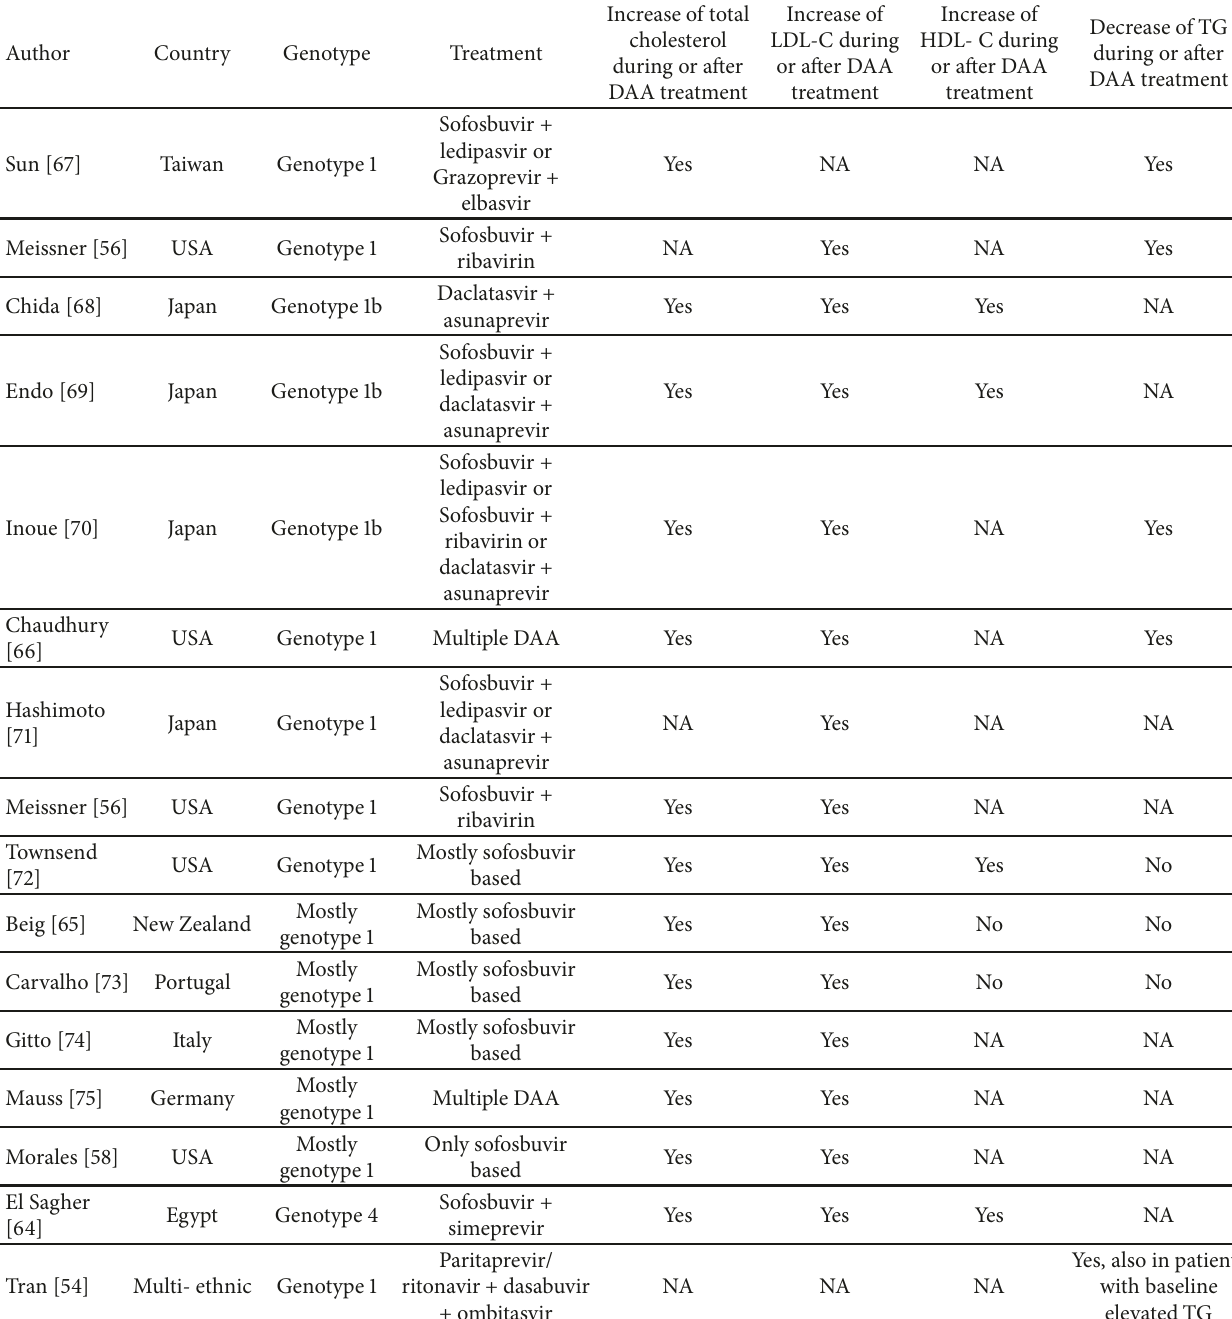
Table 2: Studies reporting the changes of lipoprotein metabolism after DAA